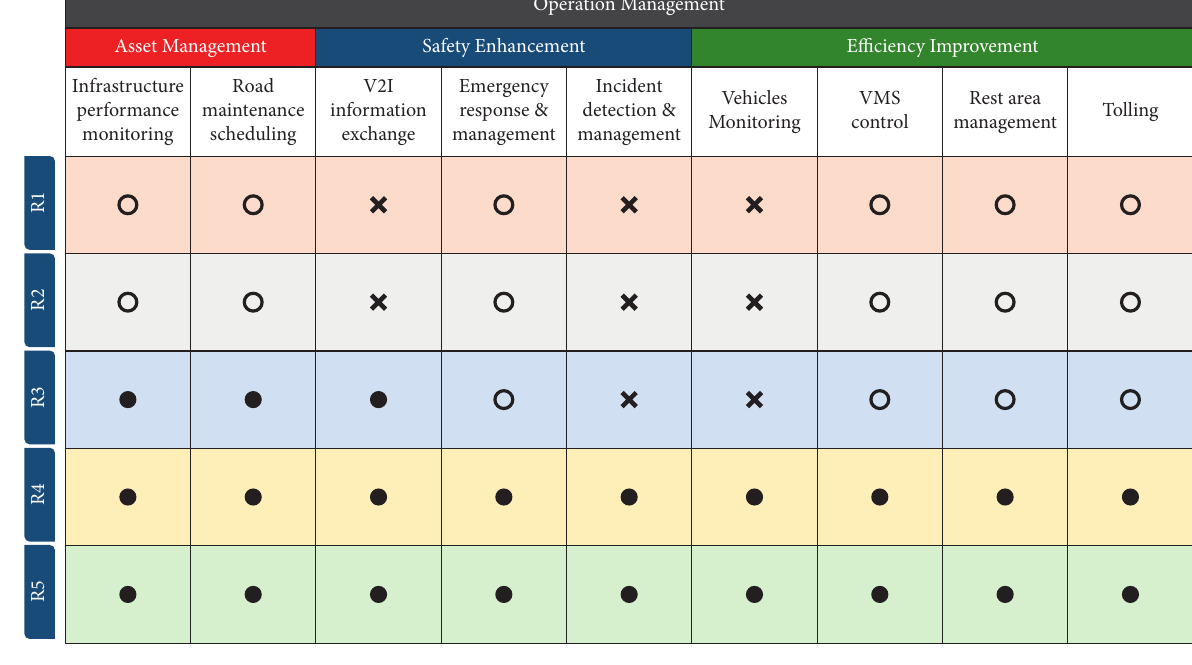
Figure 9: Operation management classification under different smart levels of